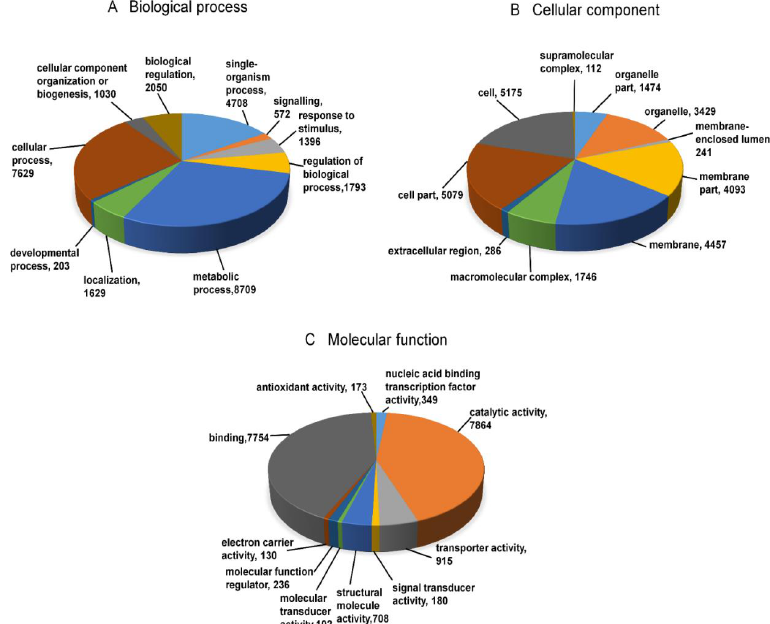
Figure 3. Distribution of Gene Ontology (GO) annotation assigned by blast 2 GO. This figure describes three GO categories namely, biological processes ( A ), cellular functions ( B ), and molecular functions ( C ).